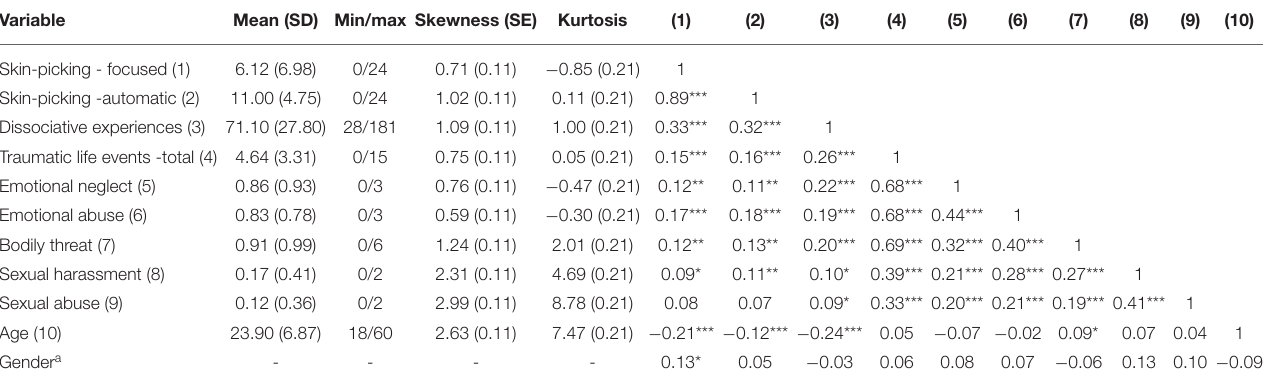
TABLE 2 | Descriptive statistics and correlation coefficients (Speraman’s rho). Variable Skin-picking - focused